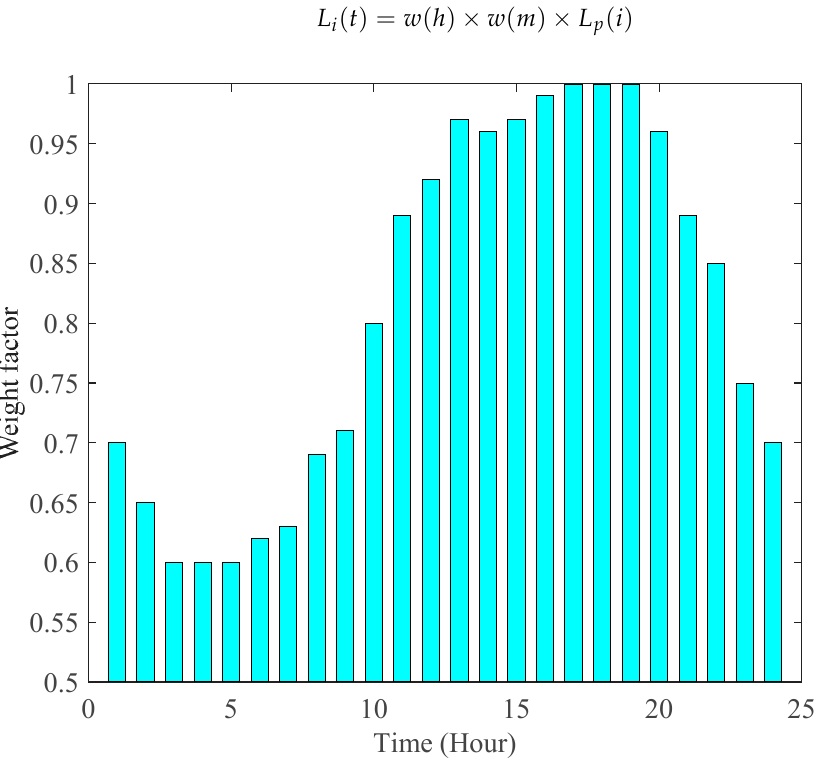
Figure 1. Hourly load factor curve.